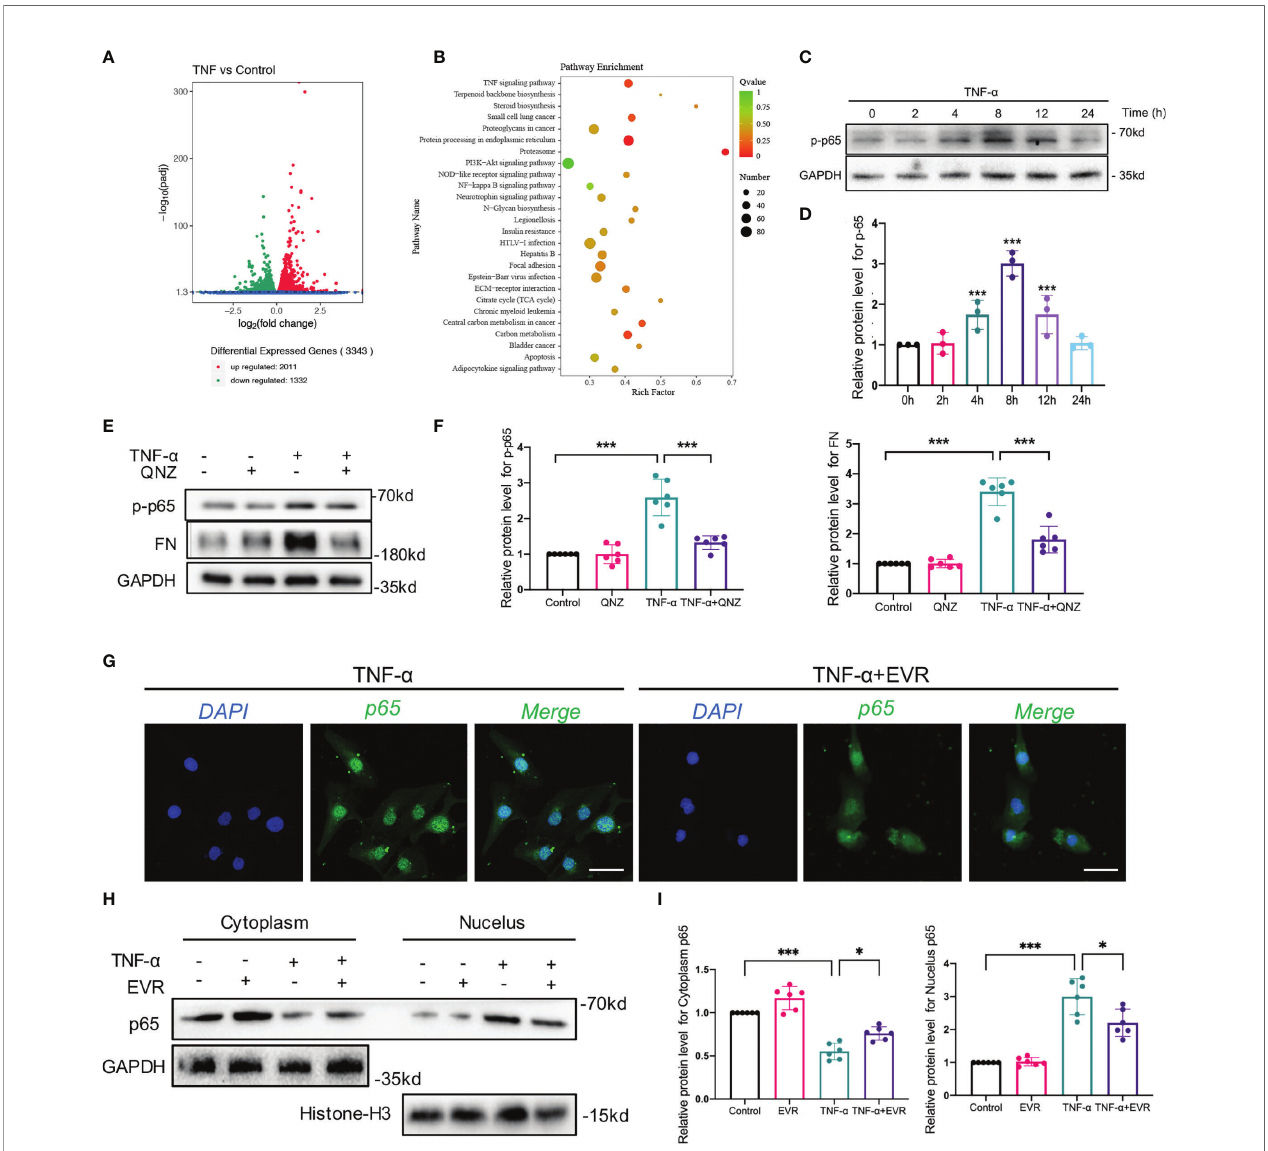
FIGURE 6 | EVR suppressed TNF- a -mediated EMT via blocking NF – k B instead of Akt signaling pathway in HK-2 cells. (A) The RNA sequencing results of differential genes in HK-2 cells treated with or without TNF- a (50 ng/ml) for 24 h ( n = 5). (B) KEGG pathway analyses results of the top 20 KEGG enriched gene pathways base on RNA sequencing results. (C) Representative Western blotting results of the expression of p-p65 in HK2 cells after TNF- a (50 ng/ml) treatment for different times. (D) Semi-quantitative analyses results of relative protein abundance of p-p65 in HK2 cells after TNF- a treatment for different times. Values represented the mean ± SD ( n = 6, *** p < 0.001). (E) Representative Western blotting results of the expressions of p-p65 and FN in HK2 cells treated with TNF- a (50 ng/ml) and/or QNZ (20 nM) for 24 h. (F) Semi-quantitative analyses results of relative protein abundances of p-p65 and FN in HK2 cells treated with TNF- a and/ or QNZ for 24 h. Values represented the mean ± SD ( n = 6, *** p < 0.001). (G) Representative IF staining images of p65 in HK-2 cells treated with TNF- a (50 ng/ml) and/or EVR (10 nM) for 24 h (scale bar: 50 m m). (H) Representative Western blotting results of p65 in cytoplasmic and nuclear fractions of HK-2 cells treated with TNF- a (50 ng/ml) and/or EVR (10 nM) for 24 h. (I) Semi-quantitative analyses results of relative protein abundance of p65 in HK-2 cells treated with TNF- a and/or EVR for 24 h. Values represented the mean ± SD ( n = 6, * p < 0.05, *** p < 0.001). TNF- a , tumor necrosis factor- a ; KEGG, Kyoto Encyclopedia of Genes